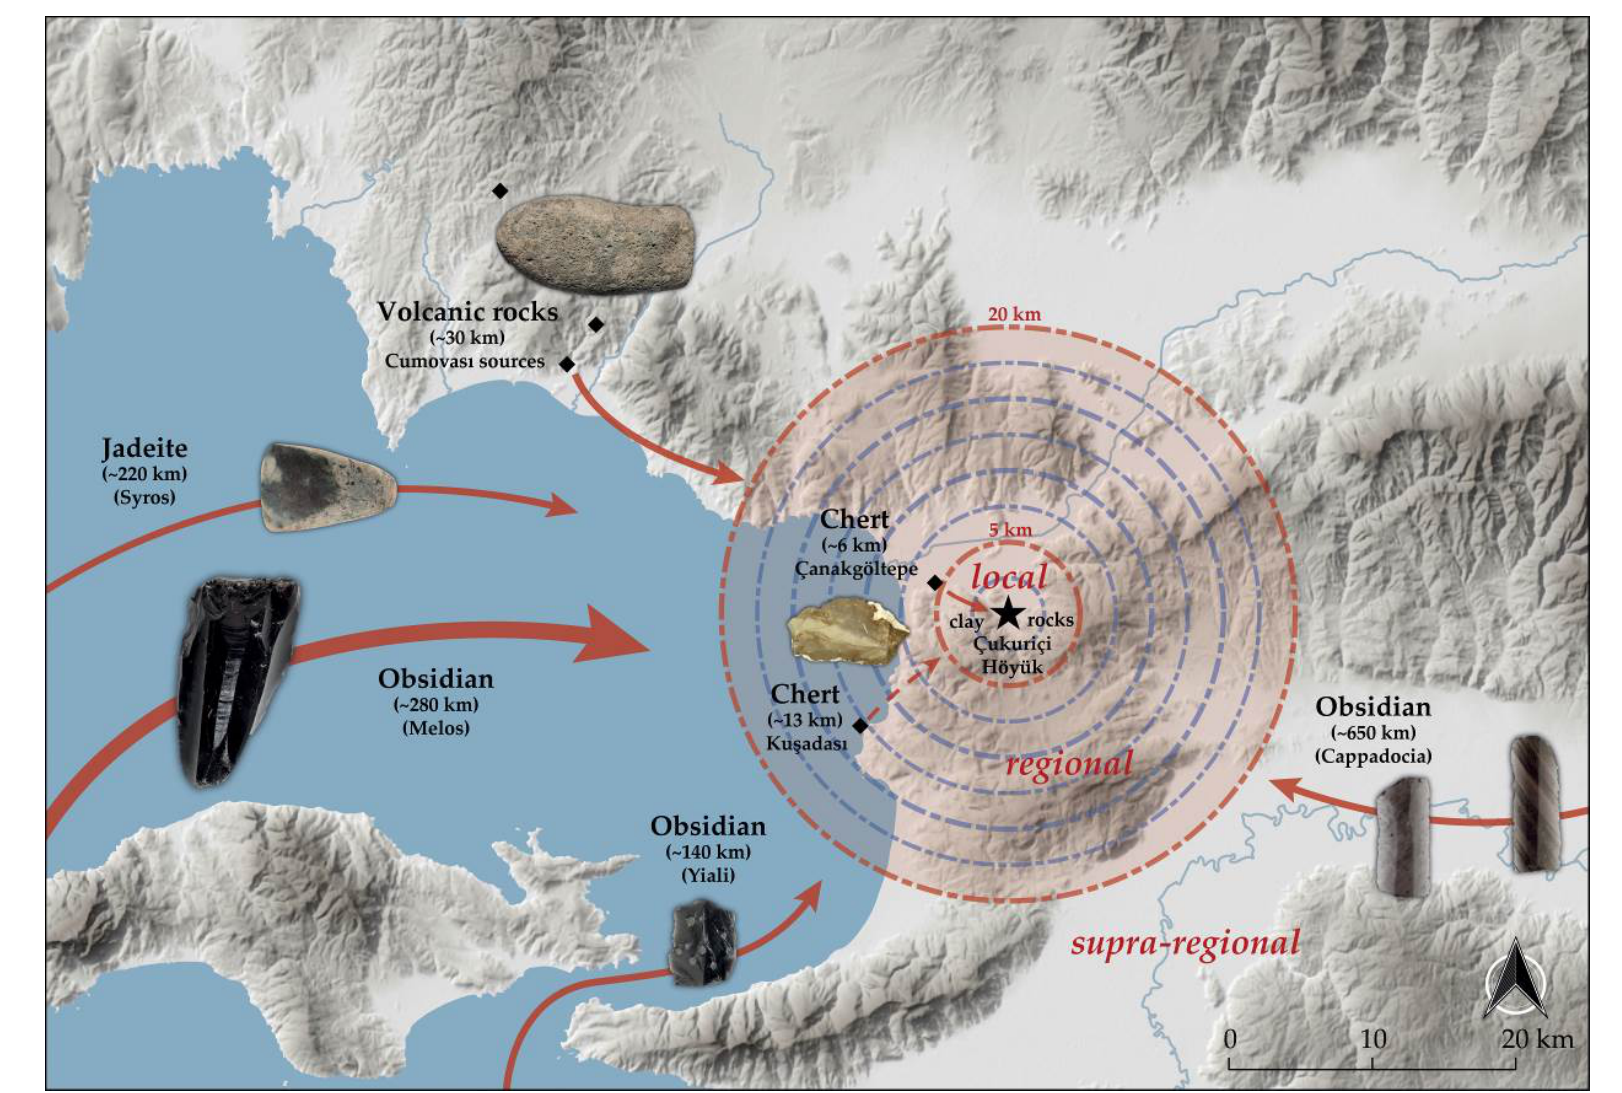
Figure 9. The local, regional and supra-regional rock procurement of the prehistoric settlement Çukuriçi Höyük (map by Ch. Schwall/M.